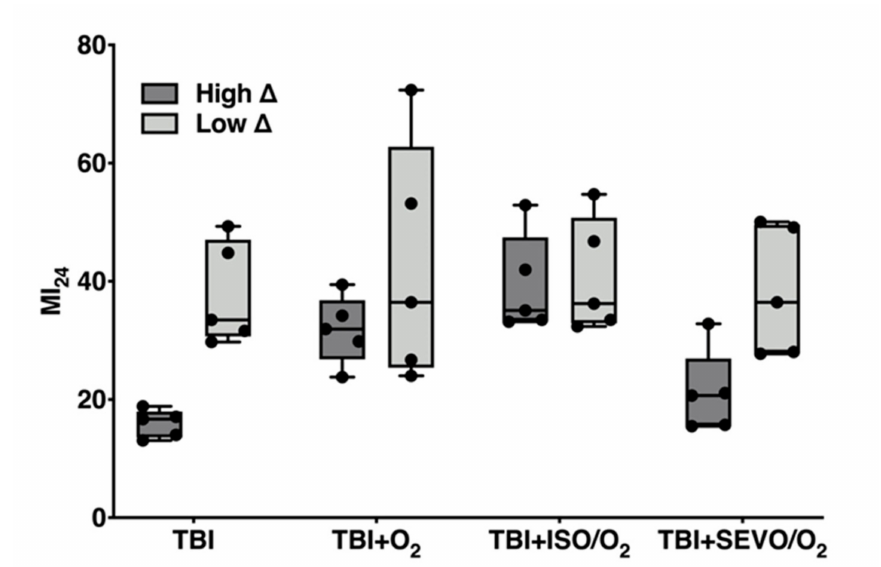
Figure 2. High ∆ and low ∆ groups respond di ff erently to O 2 , ISO / O 2 , and SEVO / O 2 exposure following TBI. Box plots of the MI 24 for the five RAL lines in the high ∆ and low ∆ groups under the indicated treatment conditions. Horizontal bars indicate the median and whiskers extend to the minimum and maximum data points.